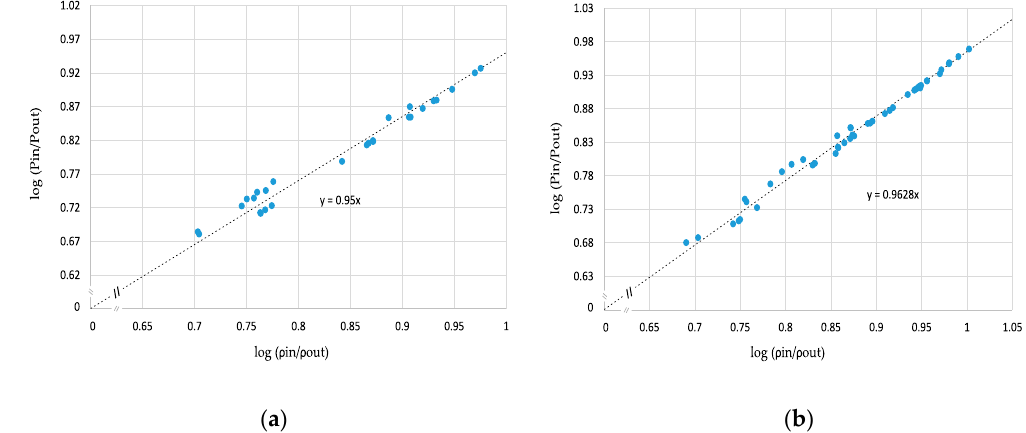
Figure 2. The polytropic coefficient in accordance with ( a ) Pure fluid; ( b ) Mixture.